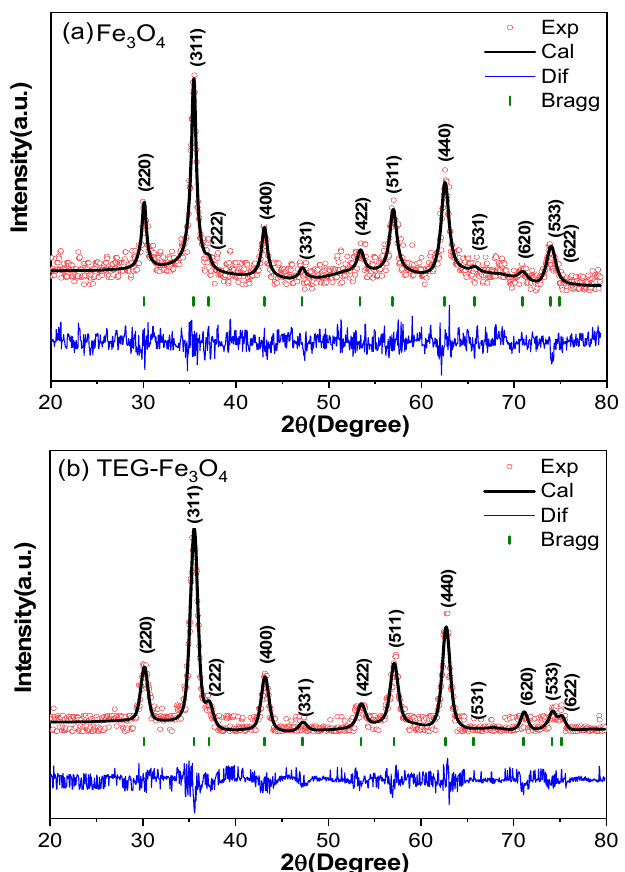
Fig. 1. Refinement of the XRD pattern of the Fe perimental data obtained by the instrument. The solid line shows the calculation result by Fullprof software. The zigzag pattern shows the difference between experimental data and calculations. The peak position is shown by vertical line symbols.